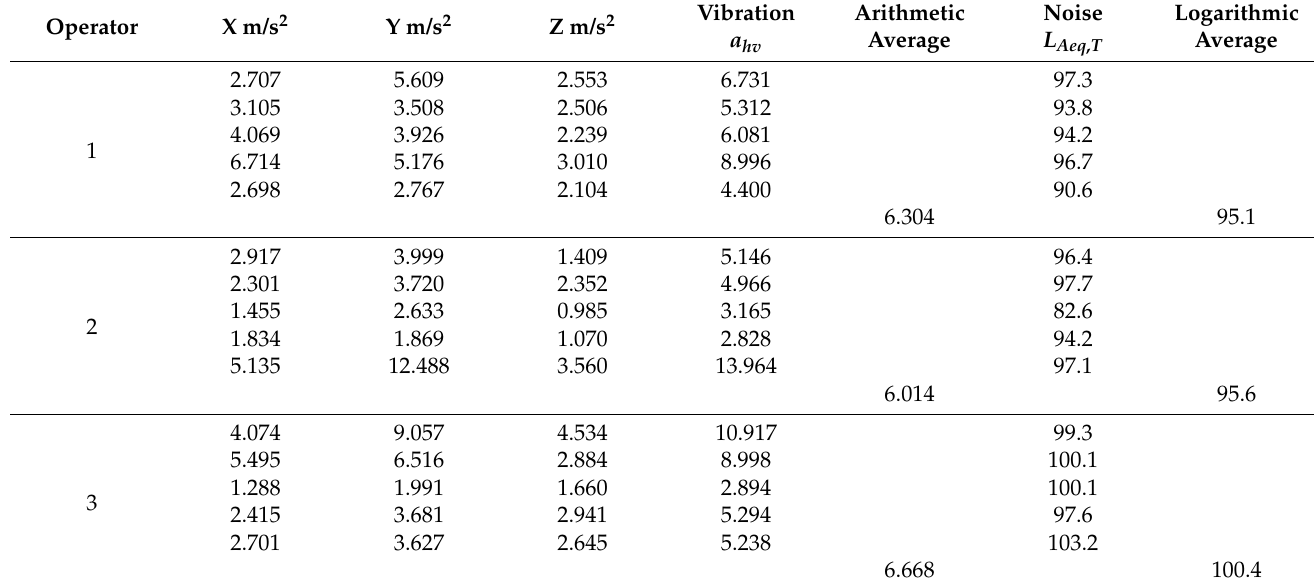
Table 3. Noise and vibration values measured in simultaneous time periods (for each operator).